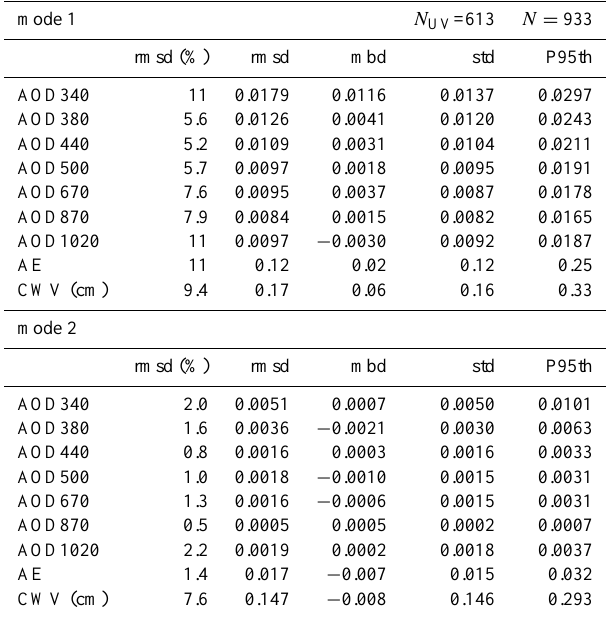
Table 3. Statistics summary (root mean square deviation – abso- lute and expressed as percentage (%), mean bias deviation, stan- dard deviation of differences, and 95th percentile) between direct sun products obtained by ESR and AERONET from the CIMEL sky radiometer for mode 1 (top) and mode 2 (bottom). The num- ber of data samples ( N ) is also indicated. N UV refers to the data available for 340 and 380 channels.